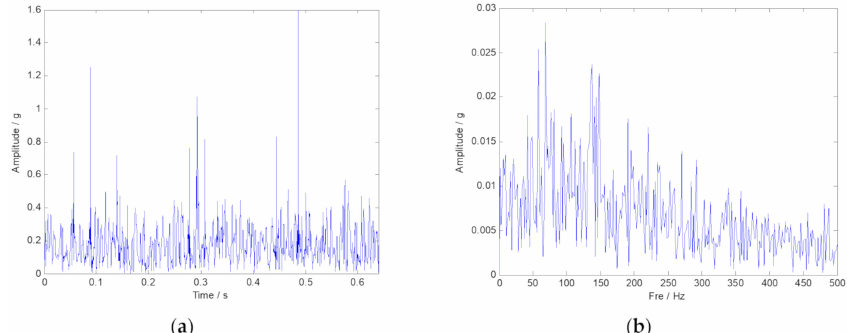
Figure 14. The time-domain and frequency-domain spectra of the original vibration signal. ( a ) Vibration signal shown in time-domain; ( b ) Vibration signal shown in frequency-domain.